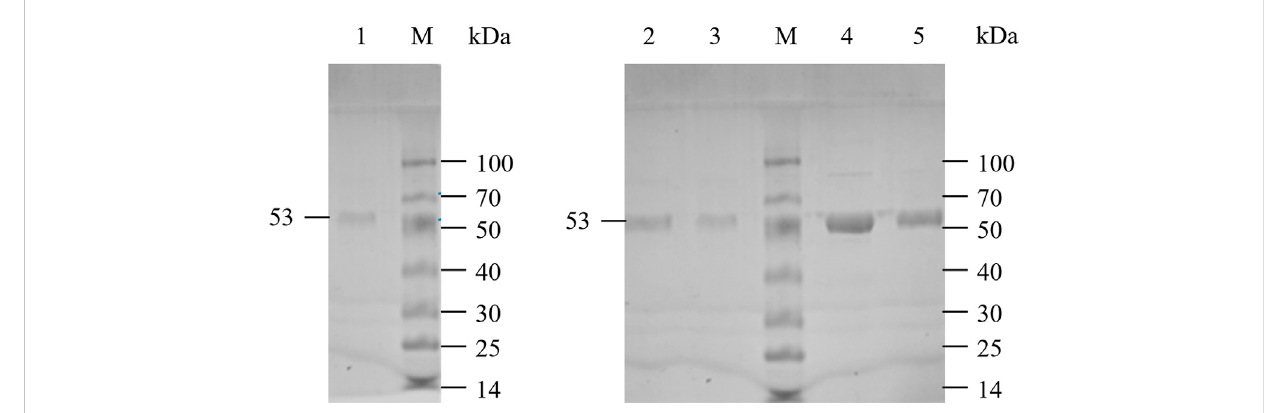
FIGURE 3 SDS-PAGE analysis of LpGAD and its variants expression. Lane M, protein molecular weight markers; lane 1, puri fi ed LpGAD; lane 2, puri fi ed mutant D295G; lane 3, puri fi ed mutant S308N; lane 4, puri fi ed mutant E313S; lane 5, puri fi ed mutant Q347H.